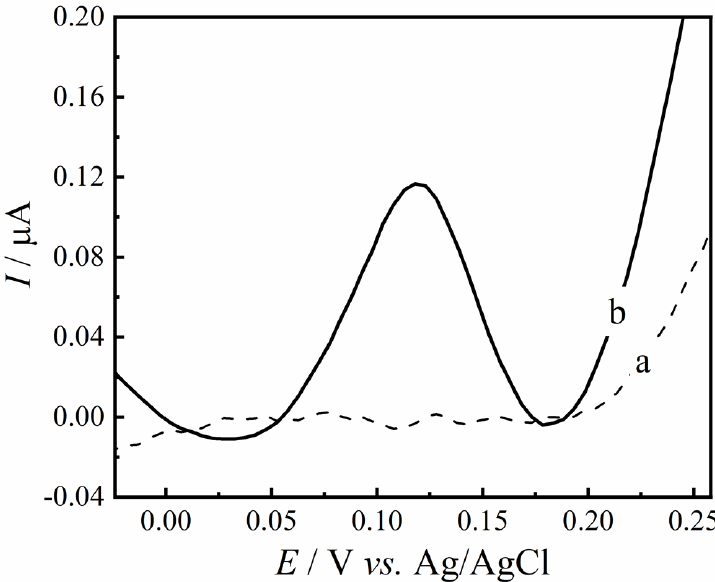
Figure 5. DPV response in the absence (a) and presence (b) of 50.0 µmol L − 1 of AChI using the GC/RC/AChE biosensor in 0.2 mol L − 1 PBS solution (pH 7.5).